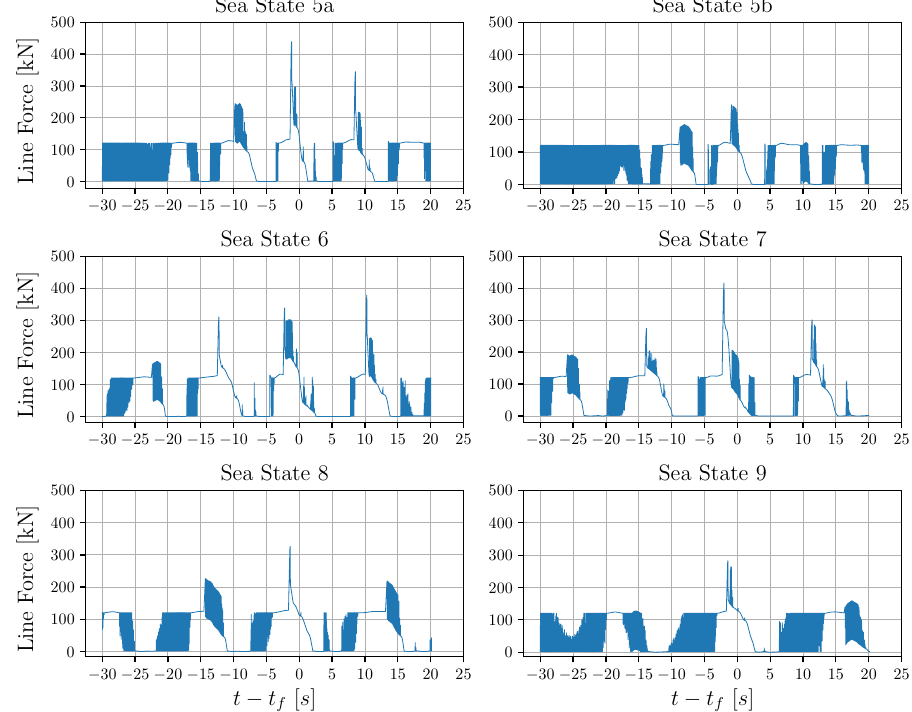
Figure 16. For all the examined sea states, the time series of the connection line force during the wave–structure interaction is